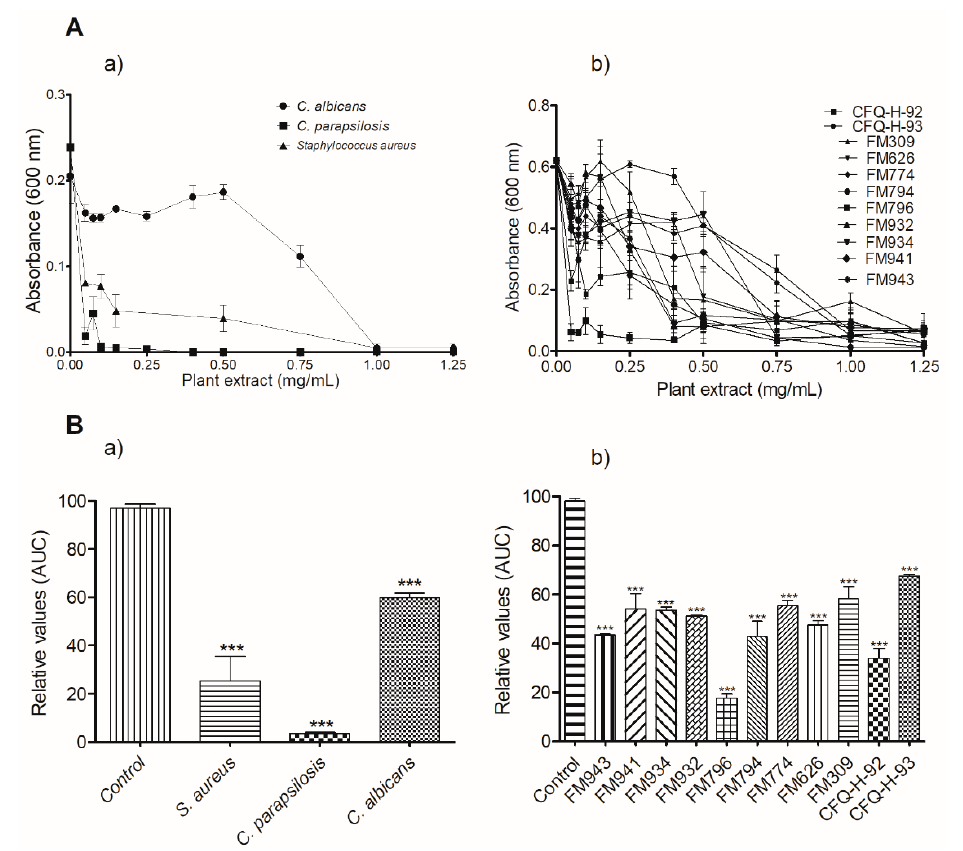
Figure 1. Antimicrobial effect of Agave nuusaviorum leaf extract. ( A ) Turbidity curves of bacterium and yeasts ( a ) and mold microorganisms ( b ). Values represent means ± SE for three replicates. ( B ) Growth percentages were obtained from a comparison of the areas under the curves (AUC) of microorganisms compared to the control (AUC established as 100%). AUC of bacterium and yeasts ( a ) and mold microorganism ( b ). Significant differences *** p < 0.001, in comparison with the control group, were detected by one-way analysis of variance (ANOVA)-Dunnett´s multiple comparison test.